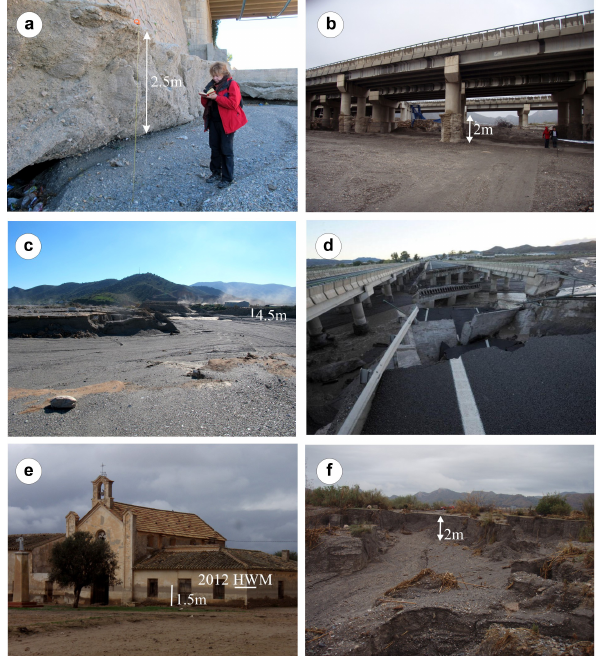
Figure 6. Pictures from the 2012 flood effects. (a) Entrenchment of 2.5m below Puerto Lumbreras Bridge. (b) In-channel gravel quarry in Nogalte fan apex showing 4.5m channel entrenchment. (c) Es- cucha Chapel in Nogalte distal fan area showing the 1.5m high water mark from 2012 event. (d) and (e) Gravel mining impact on A-7 highway bridge after 2012 event; pillars are exposed in 2m. (f) Headwards erosion due to gravel mining in the Béjar Rambla.